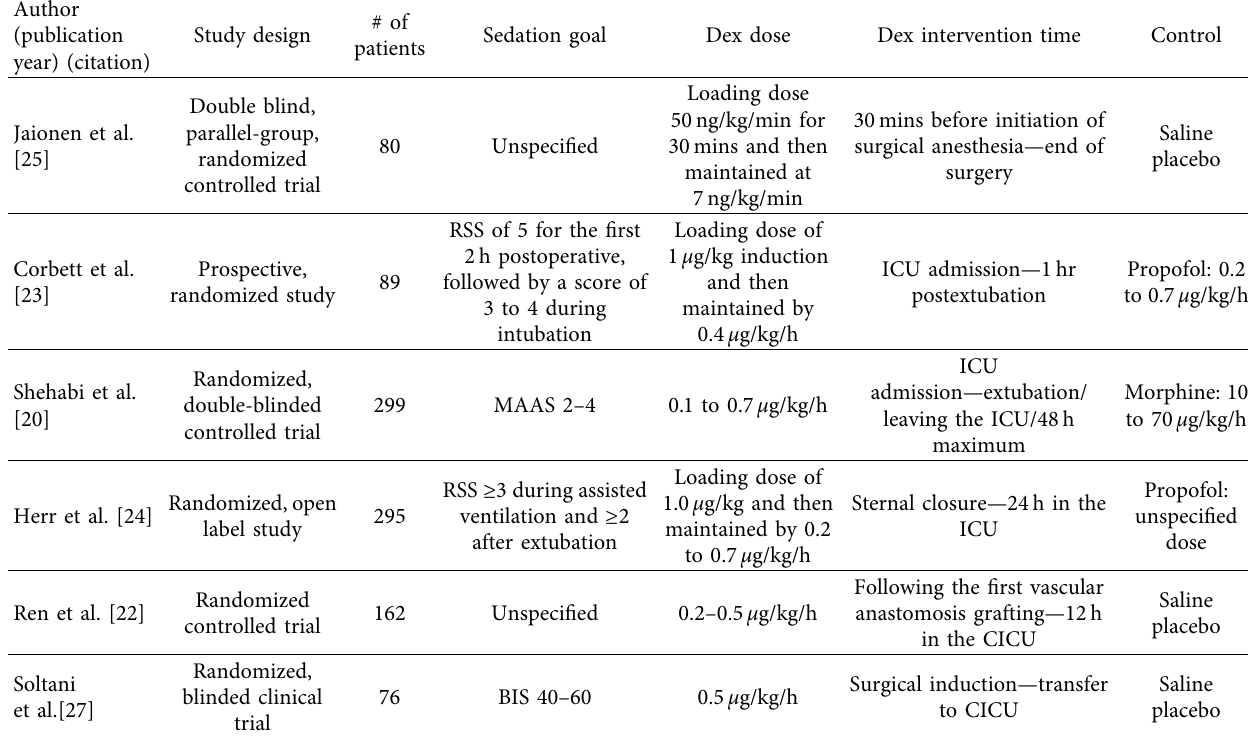
Table 1: Study design of included randomized controlled